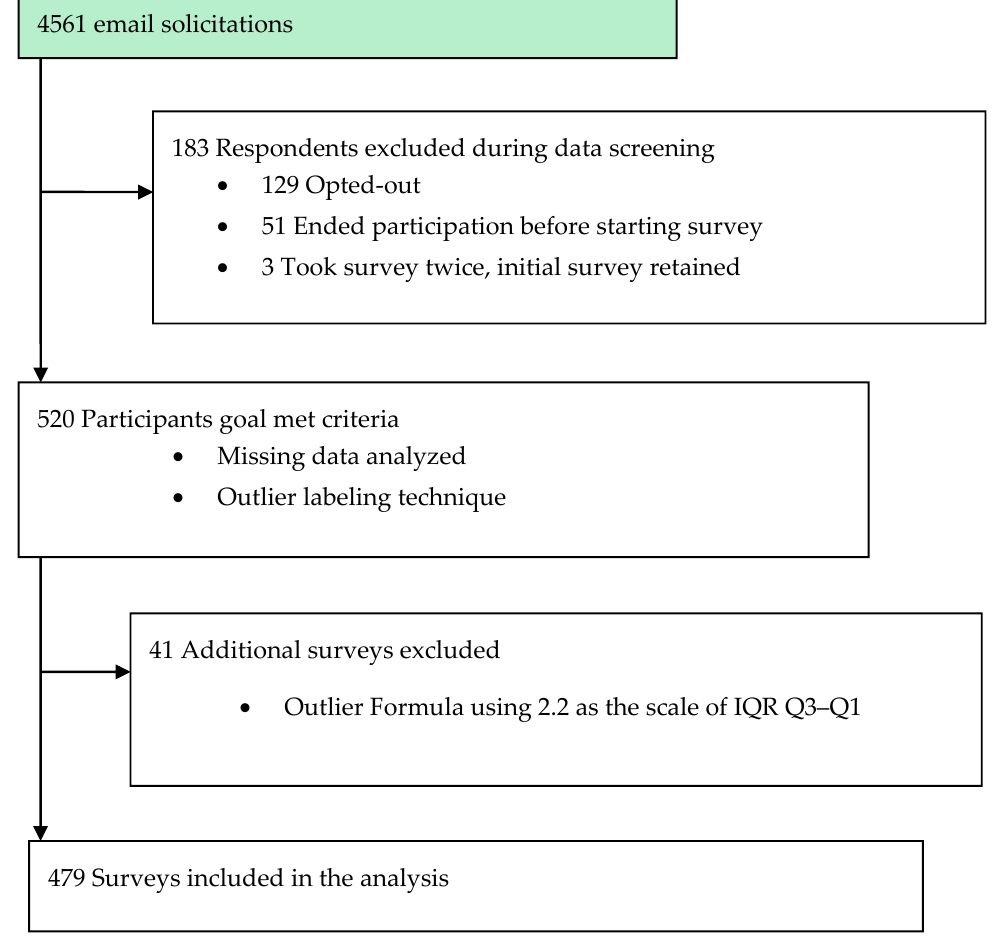
Figure 1. Flowchart of participant recruitment and case selection process.